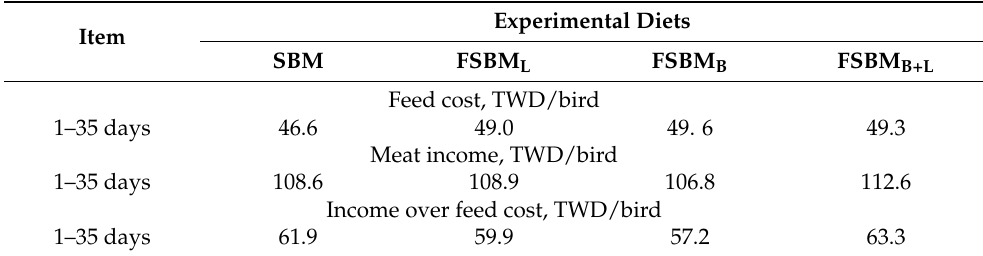
Table 6. Evaluation of the economic benefit of two-stage FSBM supplemented in